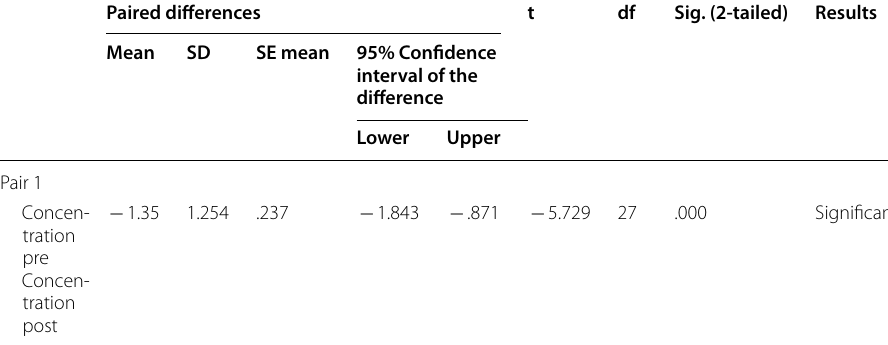
Table 7 Paired samples statistics: intuition ability. Source: SPSS 23.0 output Mean N SD SE mean Pair 1 Intuition ability pre 6.29 Intuition ability